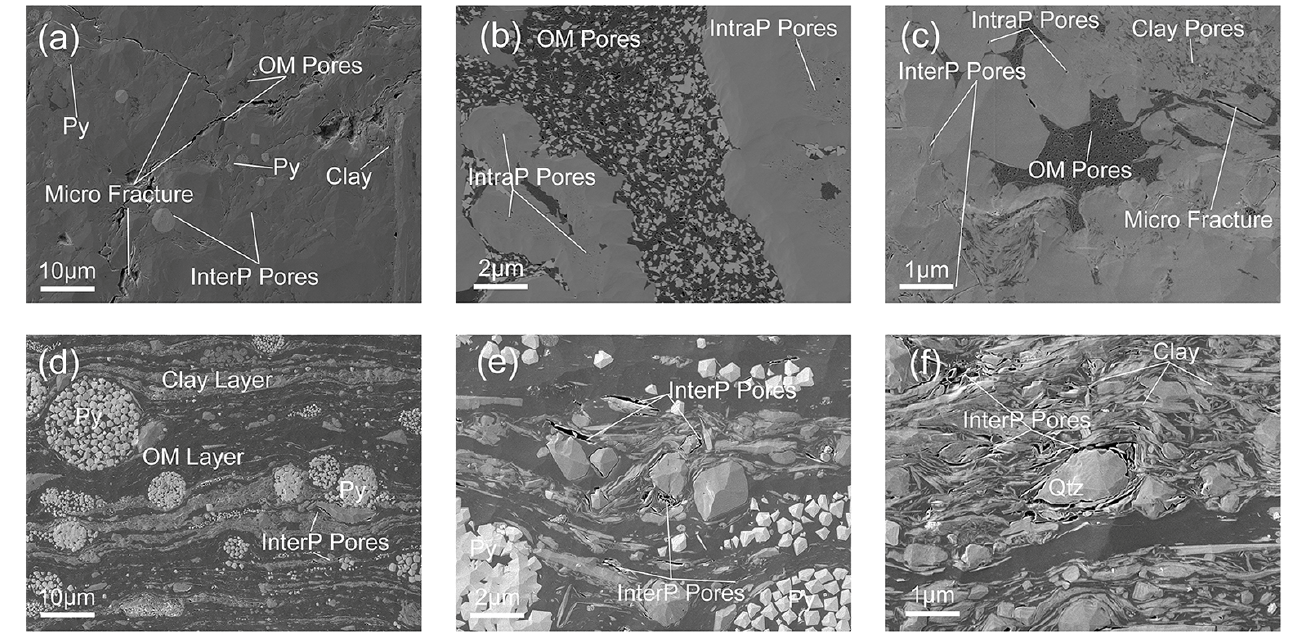
Figure 4. SEM images of marine shale samples ( a – c ) continental shale samples ( d – f ). OM = Organic matter, InterP = interparticle, IntraP = intraparticle, Py = pyrite, Qtz = Quartz. In detail, micro fracture developed in the marine shale ( a ); OM pores supported by the detrital quartz ( b ); OM pores distributed in rigid quartz framework ( c ); the lithological stratification of clay layer, OM layer, and pyrite layer ( d ); interparticle pores developed along with clay and quartz ( e ); the oriented direction of clay minerals and the main pore type (inorganic pore in clay mineral) in the continental shale ( f ).